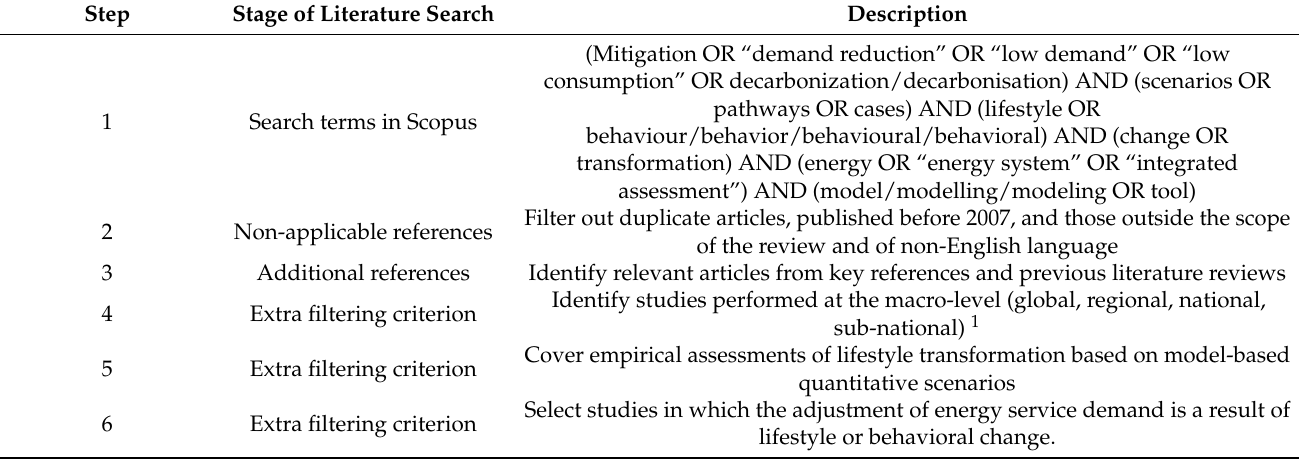
Table 1. Description of steps followed in identifying, compiling, and filtering academic papers for the literature